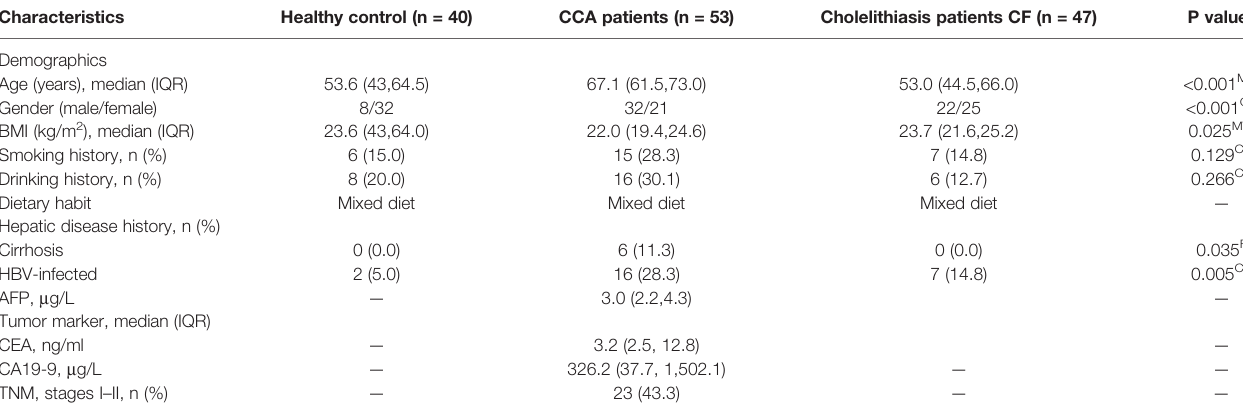
† P value was compared between CCA patients and healthy control. Statistical methods annotation in the table: CS, chi-square test; F, Fisher ’ s exact test; MW, Mann – Whitney test.